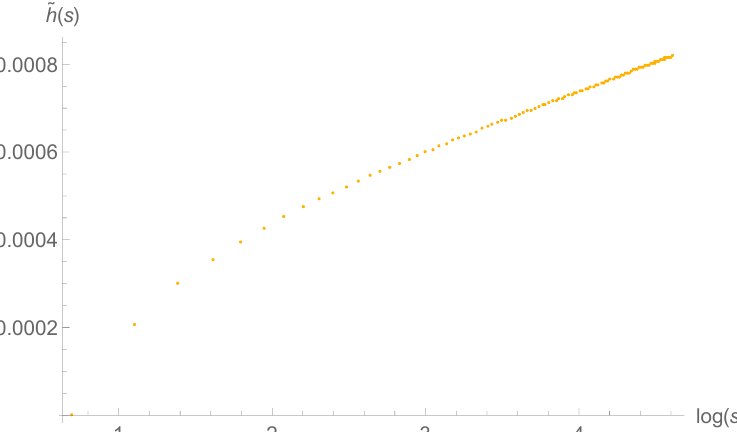
Figure 11. The anomalous dimension of the higher-spin operators as a function of their spin. The plot is around the higher-spin limit (4.8). We observe that for large enough spin the anomalous dimension is proportional to the log of the